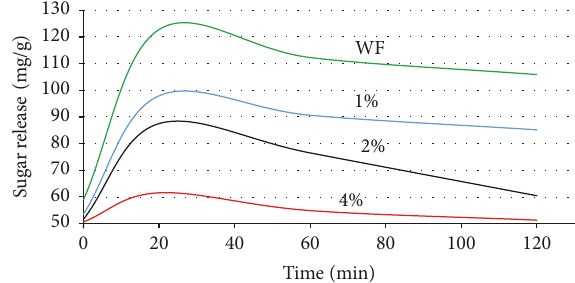
Figure 2: In vitro glycemic response study of control and 𝛽 -glucan added flour. WF = wheat flour; 1% = 𝛽 -glucan added at 1% level to wheat flour; 2% = 𝛽 -glucan added at 2% level to wheat flour; 4% = 𝛽 -glucan added at 4% level to wheat